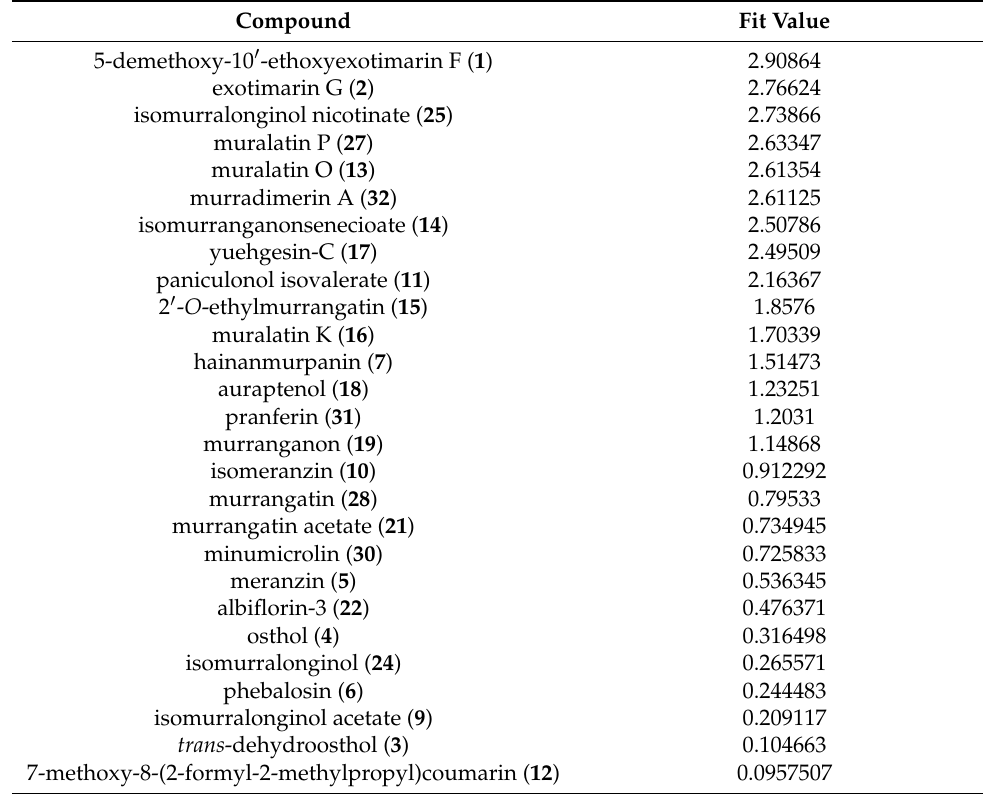
Table 5. Pharmacophore model screening